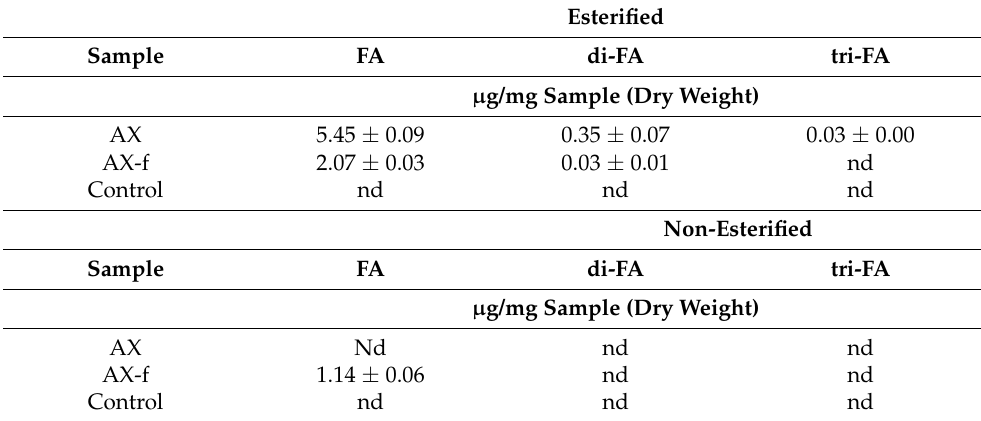
Table 1. The esterified and non-esterified phenolic acids content in AX and